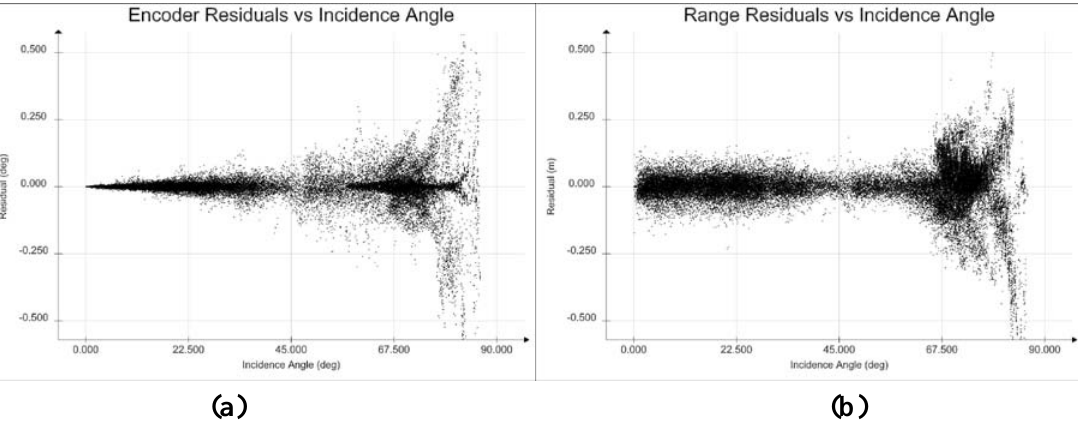
Figure 6. Residuals Versus Planar Incidence Angle (a) Encoder Angle (b)